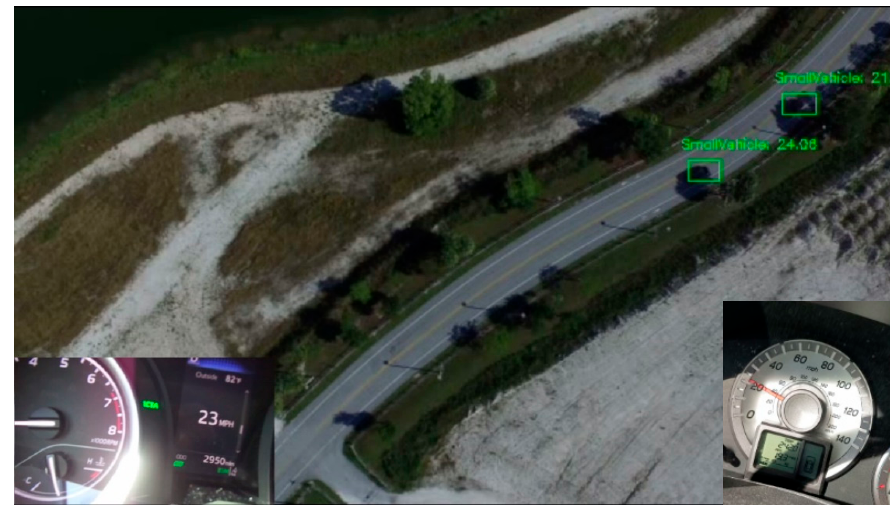
Figure 6. Speed estimation results.